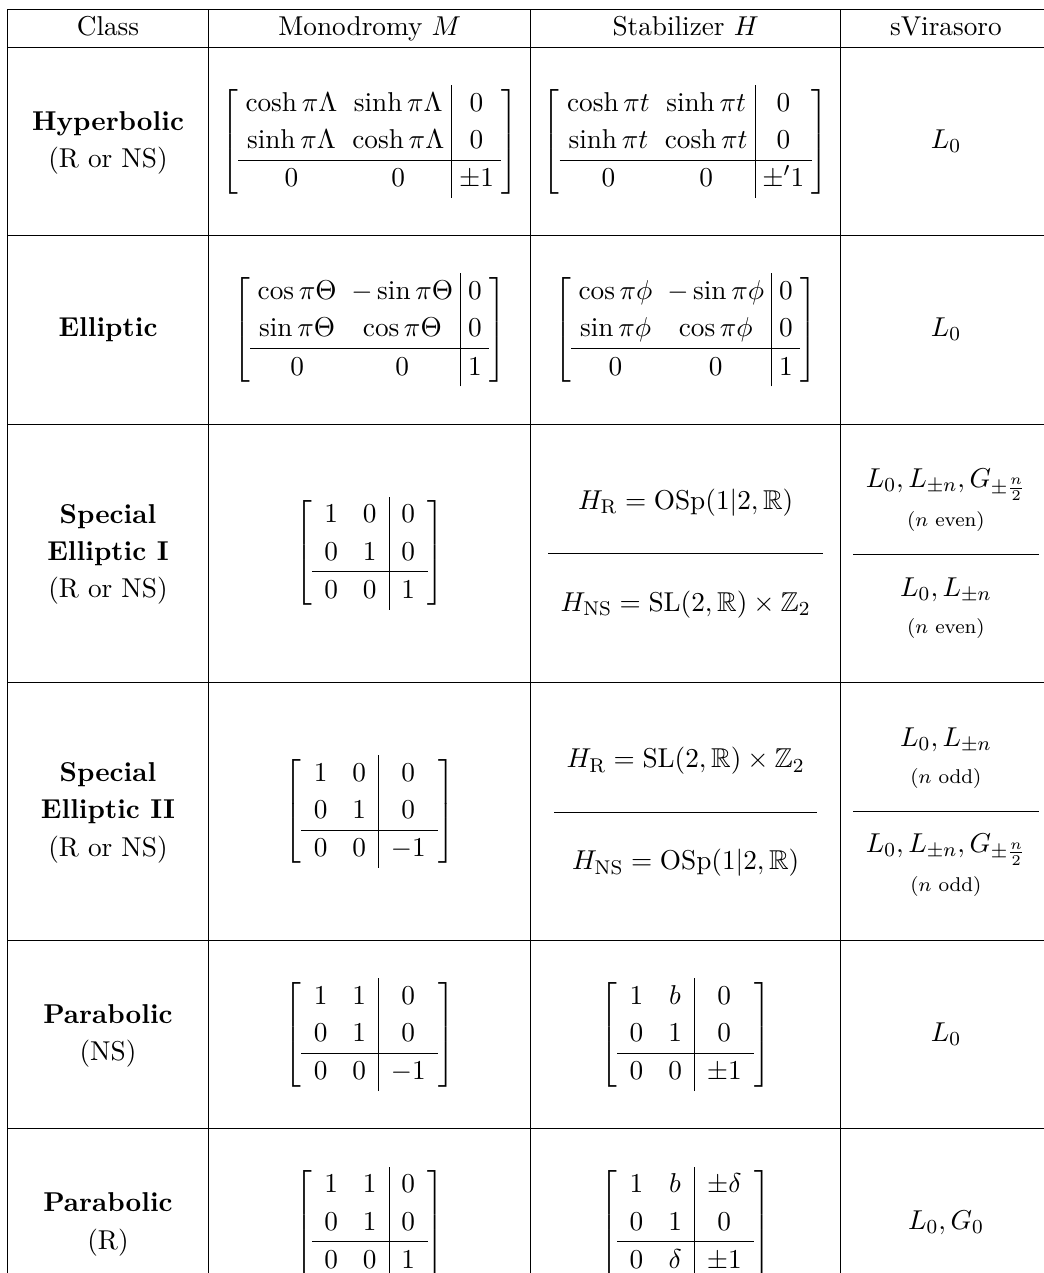
Table 1 . Inequivalent monodromy matrices M identified with (constant-representative) N = 1 Virasoro coadjoint orbits. We list the stabilizer subgroups H = { S ∈ OSp (1 | 2 , R ) | MS = SM } preserving these monodromy matrices. These subgroups are identified with the N = 1 Virasoro subalgebras preserving the value of the super-Schwarzian derivative. The NS-type special elliptic orbits are the only exceptions to this rule. In these cases, the correct stabilizer is denoted by H and it preserves M ( − ) F : M ( − ) F S = SM ( − ) F